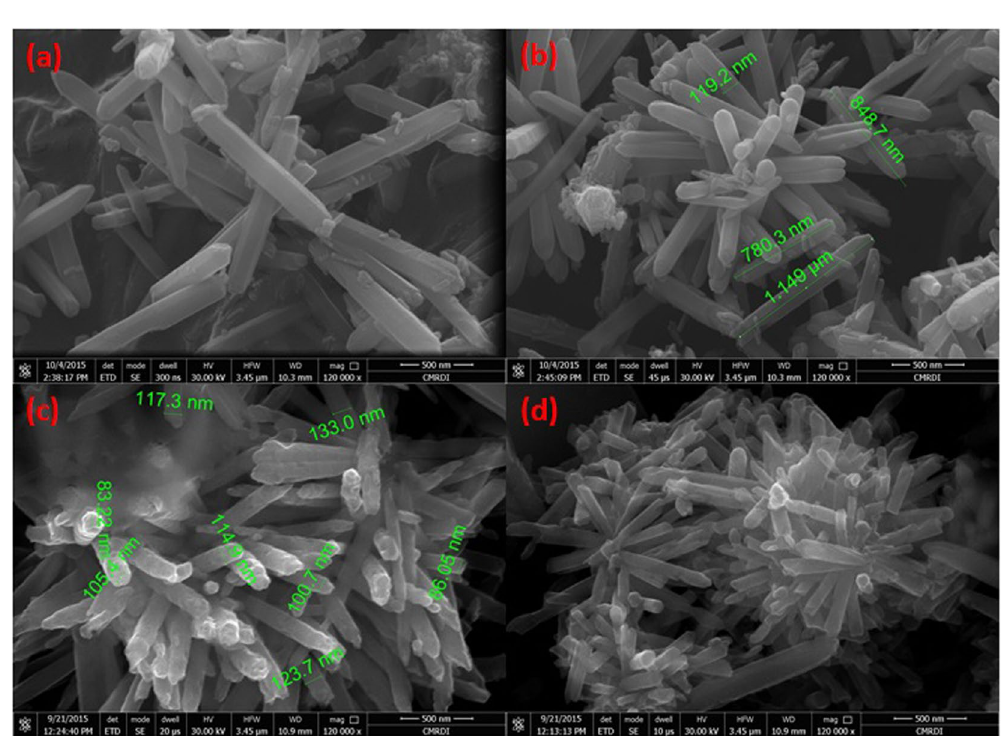
Figure 7. FESEM images of hexagonal ZnO nanorods ‘with pencil like tip’ before reaction ( a , b ), and deformed (chemically etched) ZnO nanorods after reaction that has not self-assembled to nanoplatelets ( c , d